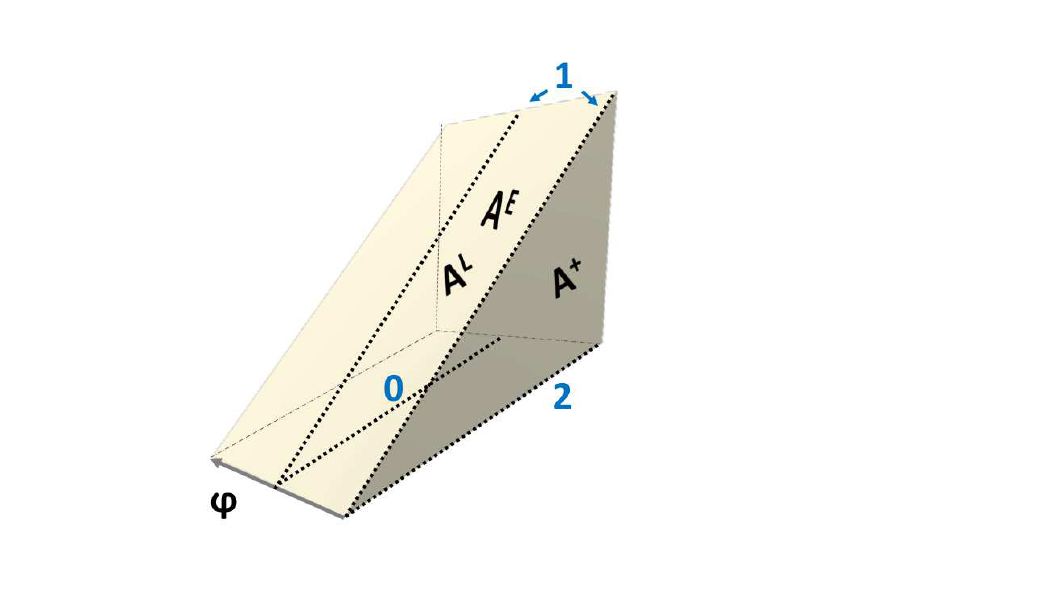
Figure 3 . The three-dimensional slice of the fundamental domain D 2 for the BC 2 Calogero- Sutherland model in u -space. Front and the back side of the wedge should be identified. The fixed points (walls) under the action of w 2 and w 1 are shown as bold dashed lines. Fixed points of w 2 fall into two disconnected components which carry the labels 0 and 2. The fixed points of w 1 on the other hand form a connected set that intersects our 3-dimensional slice in two lines labeled by 1. The shaded area in front is the Weyl chamber A + 2 . It is bounded by the walls ω 1 and ω 2 . The shifted Weyl chamber A L 2 = ˜ A + 2 is bounded by the walls ω 0 and ω 1 . The subset A E 2 is the 2-dimensional semi-infinite strip of width π on top of the wedge. It is bounded by pieces of wall ω 1 only, except in the